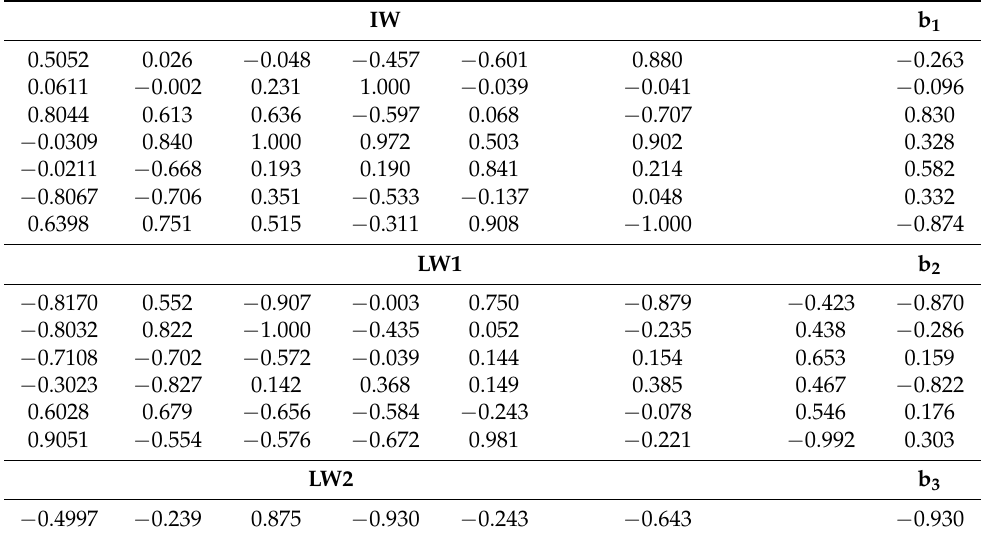
Table 8. Final weights and bias values of the ABC-ANN model for ( M n / M p,beam